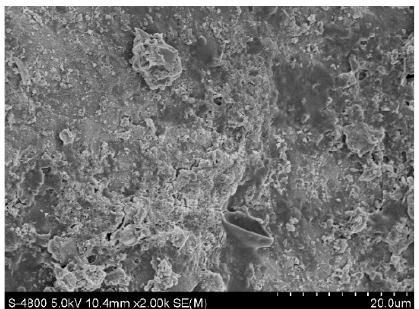
Figure 11. Magnesia matrix after treatment.